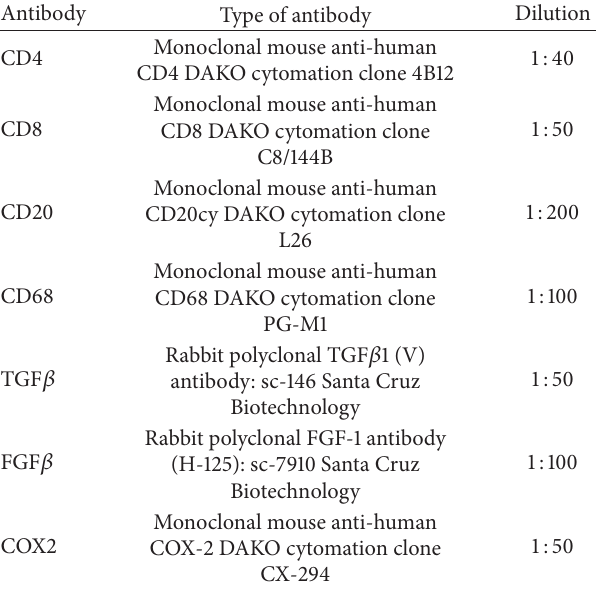
Table 1: Antibodies used in the study for immunohistochemical